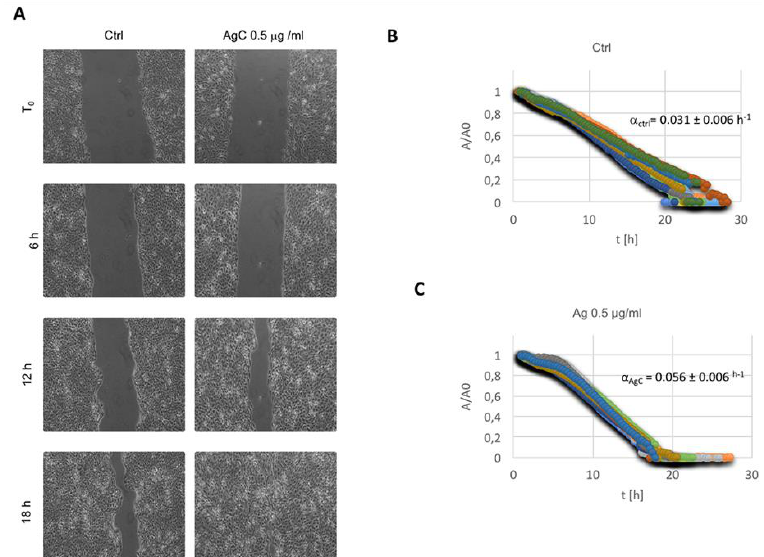
Figure 3. E ff ect of AgC on wound closure dynamics. ( A ) Representative phase contrast microscopy